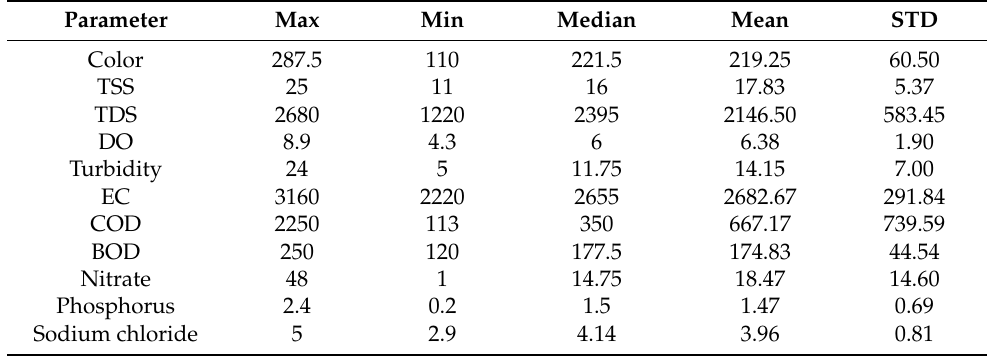
Table 4. Water quality characteristics from the samples collected from 0.75 m column depth.